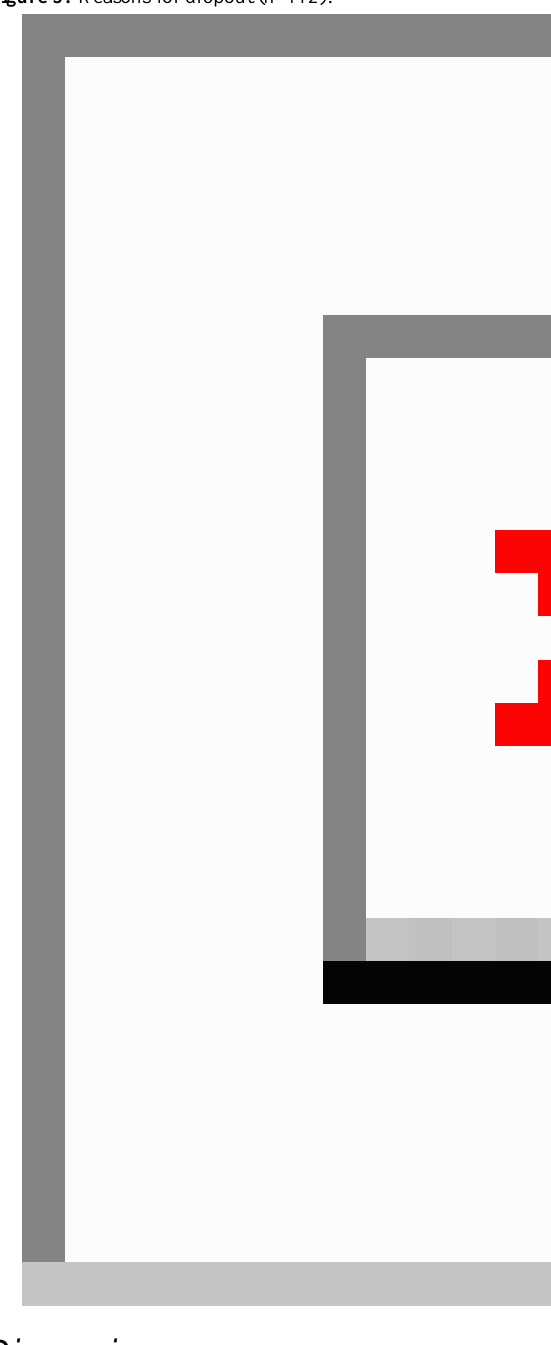
Figure 3. Reasons for dropout